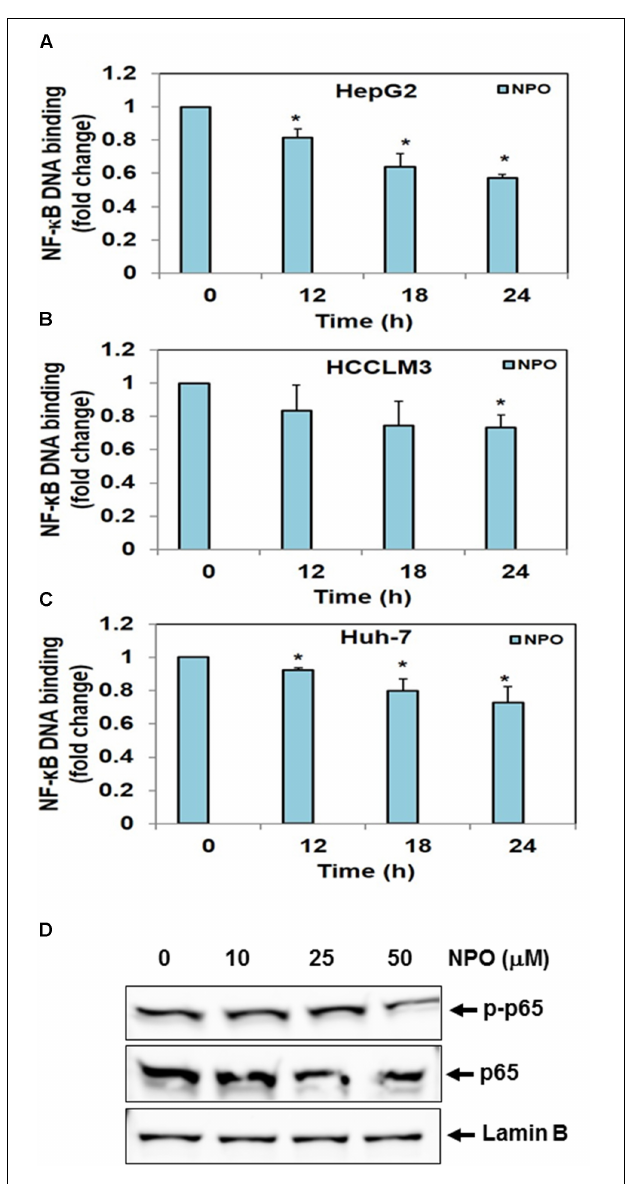
NPO Decreases p65 Phosphorylation in HCC